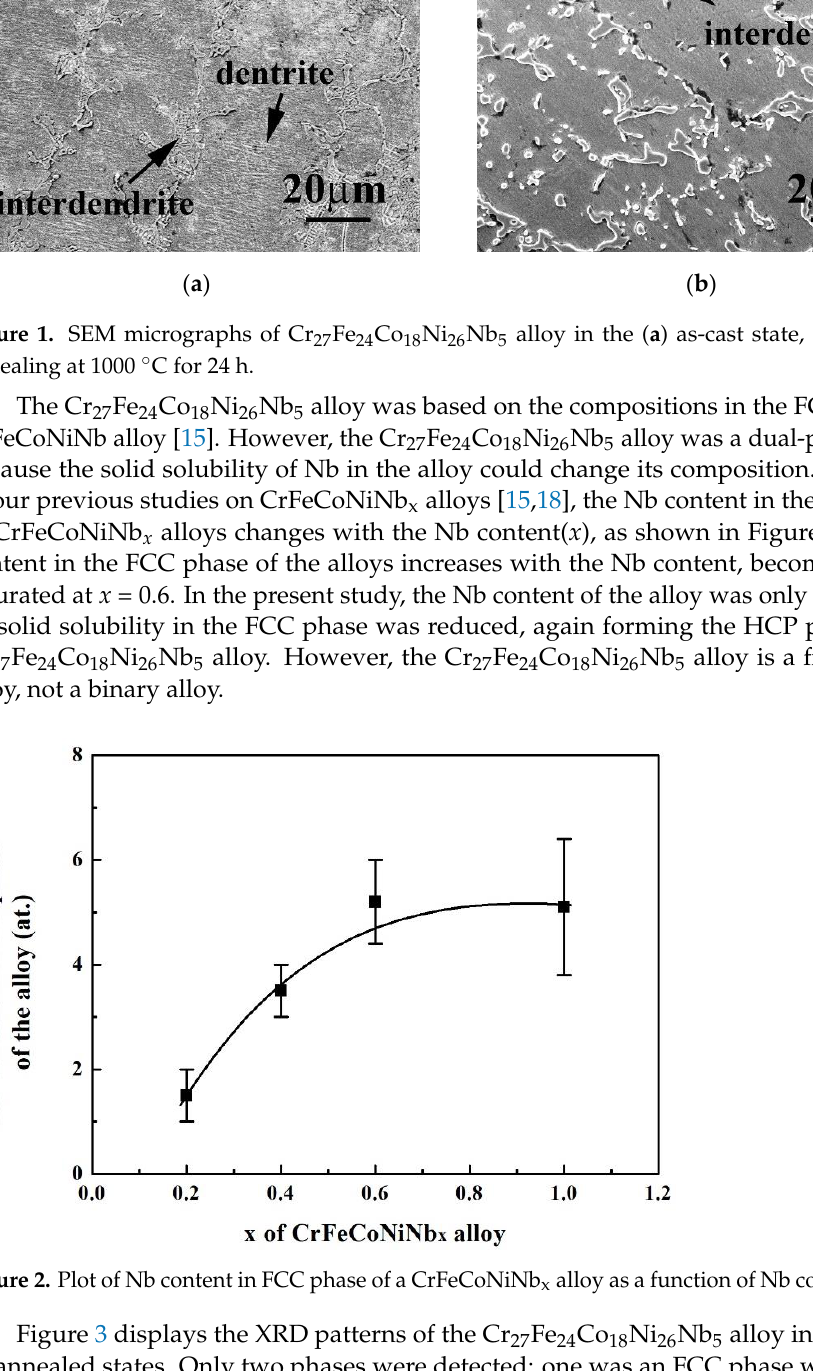
Figure 2. Plot of Nb content in FCC phase of a CrFeCoNiNb x alloy as a function of Nb content [15,18].